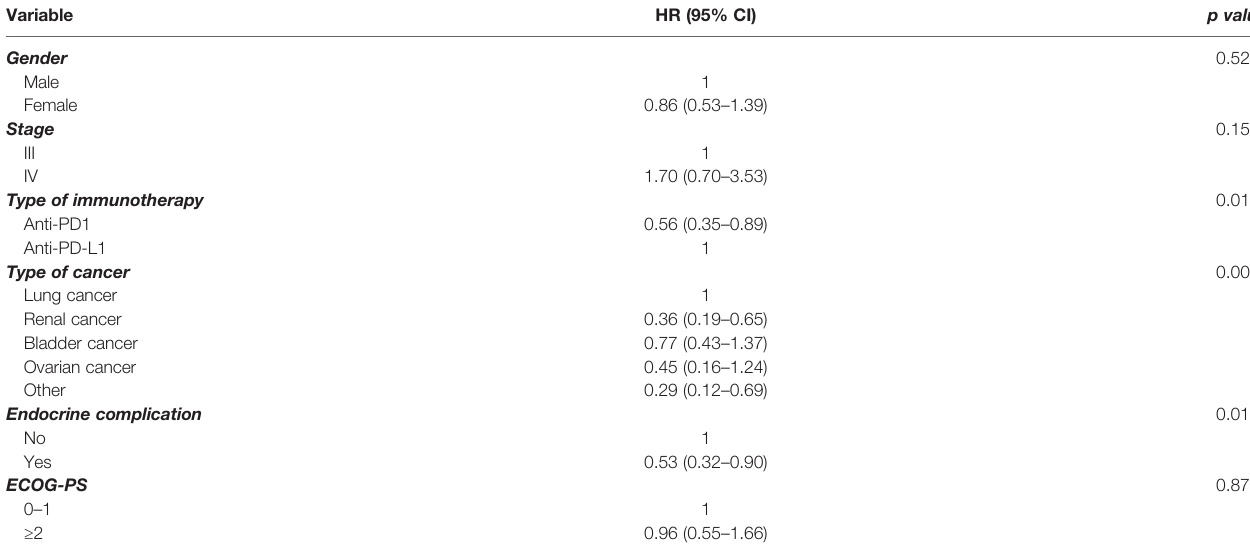
TABLE 3 | Multivariate analysis for overall survival